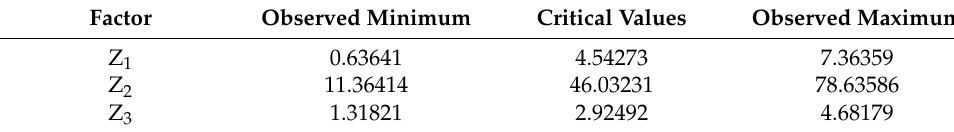
Table 7. Critical points leading to maximum CEC central composite